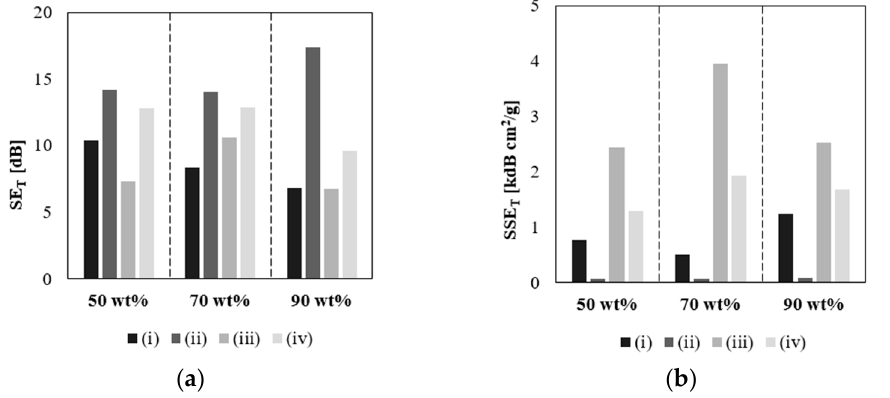
Figure 7. Schematic representation of ( a ) aligned/compact (i, ii) and ( b ) chaotic/porous (iii, iv) nanoarchitecture. By making the nanostructure porous, reflection decreases and absorption increases [19]. Both for compact films at low filler content and porous samples, the chaotic structure allows better absorption. At the same time, the randomly oriented nanostructure reduces the reflection capacity of the material due to a worse alignment of the nanoplatelet of the surface. In the case of compact samples, a higher compaction pressure applied during the fabrication process leads to a higher level of alignment of the nanoplatelet, which results in a higher reflection capacity of the material.